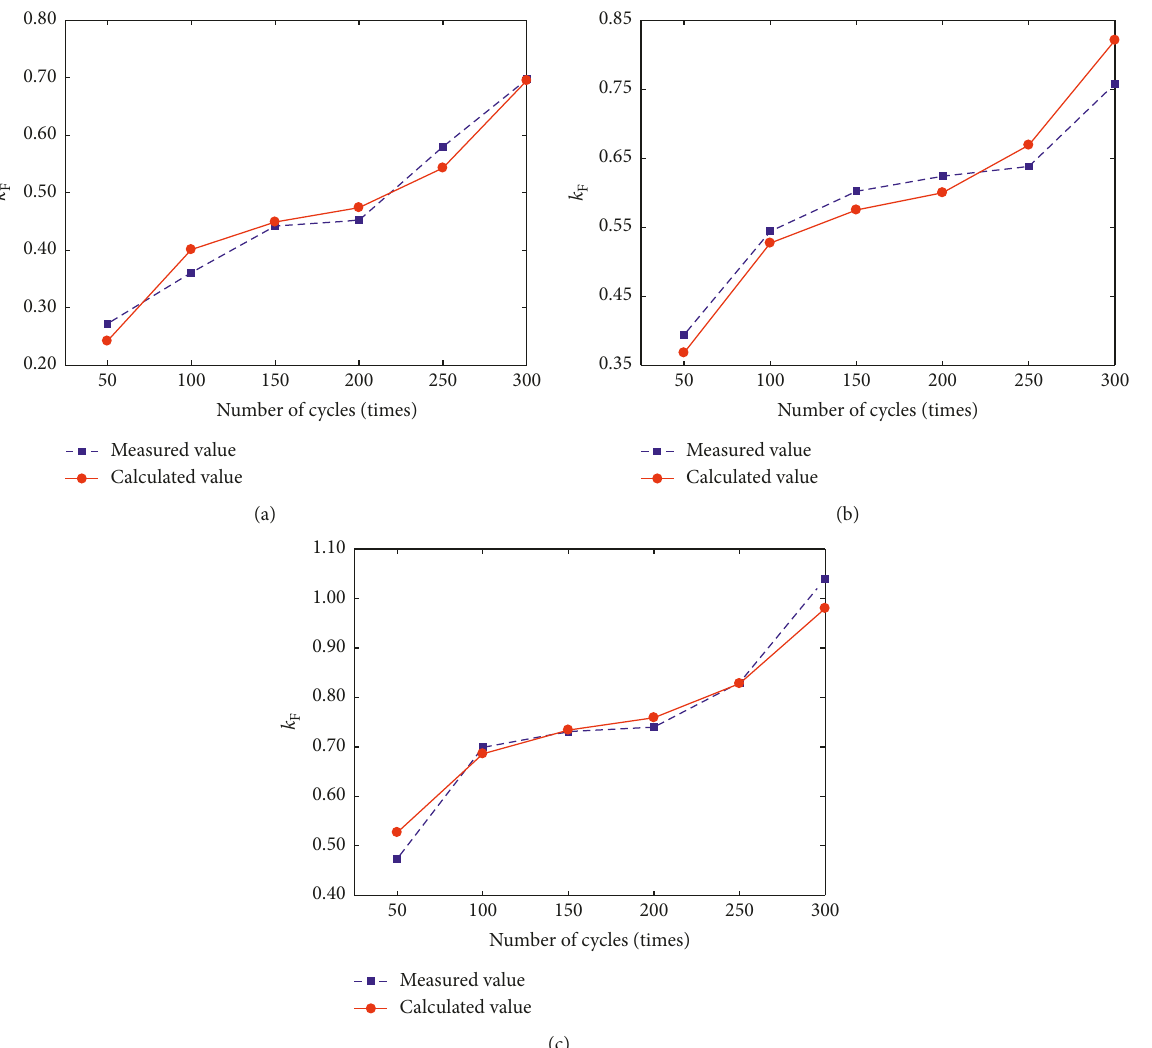
F in FC mode. (a) S1-FC, (b) S2-FC, and